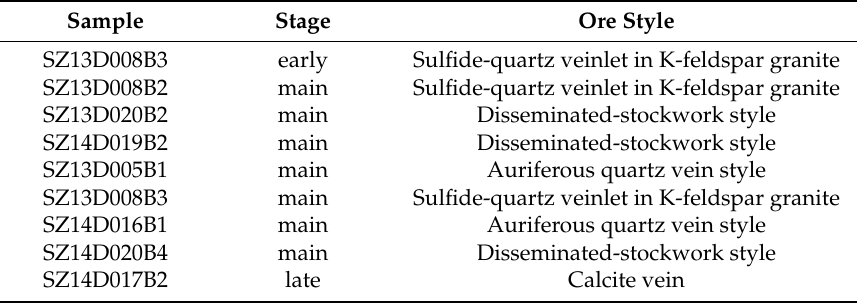
Table 1. The basic information of the samples in this